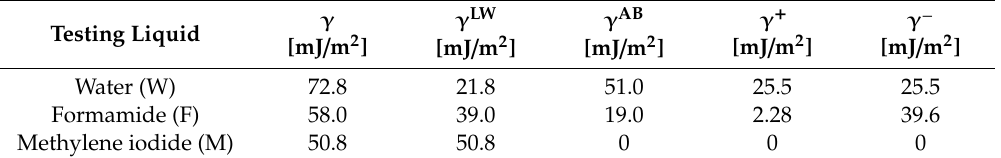
Table 1. Values of the surface tension components of the testing liquids [25].